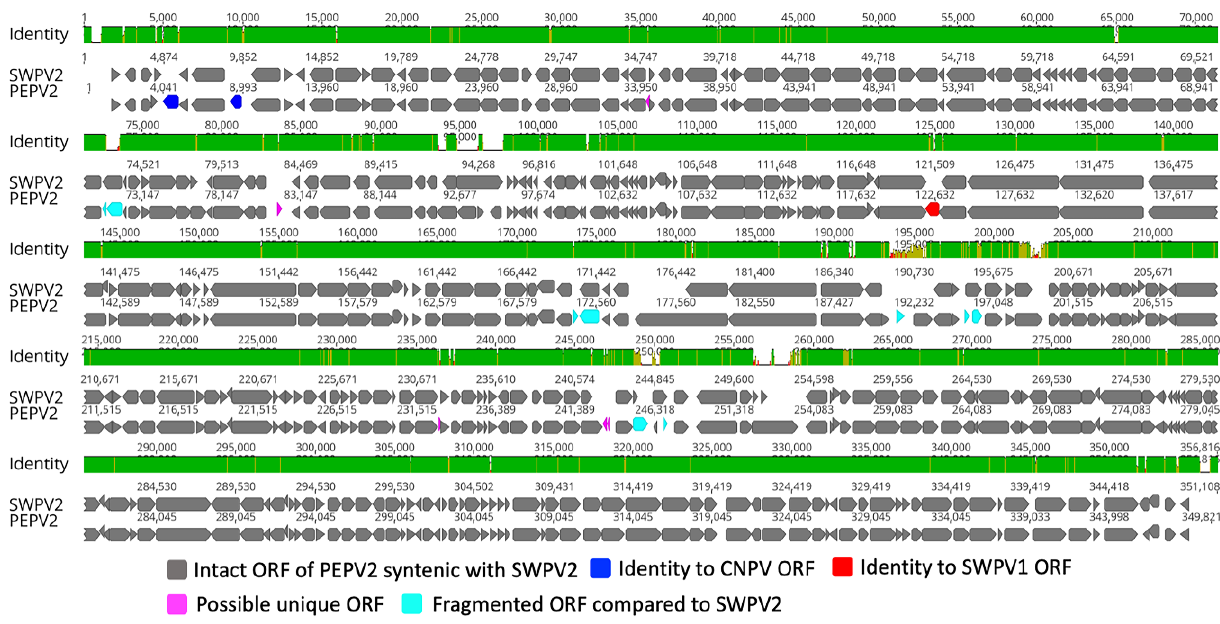
Figure 1. Genomic illustration of the novel PEPV2. The arrows depict the direction of transcription of genes and open reading frames (ORFs). Each gene or ORF is colour coded, as indicated by the key in the legend. The top graph represents the mean pairwise sequence identity over all pairs in the column between PEPV2 and SWPV2 (green: 100% identity; mustard: ≥ 30% and <100% identity; red: <30% identity).